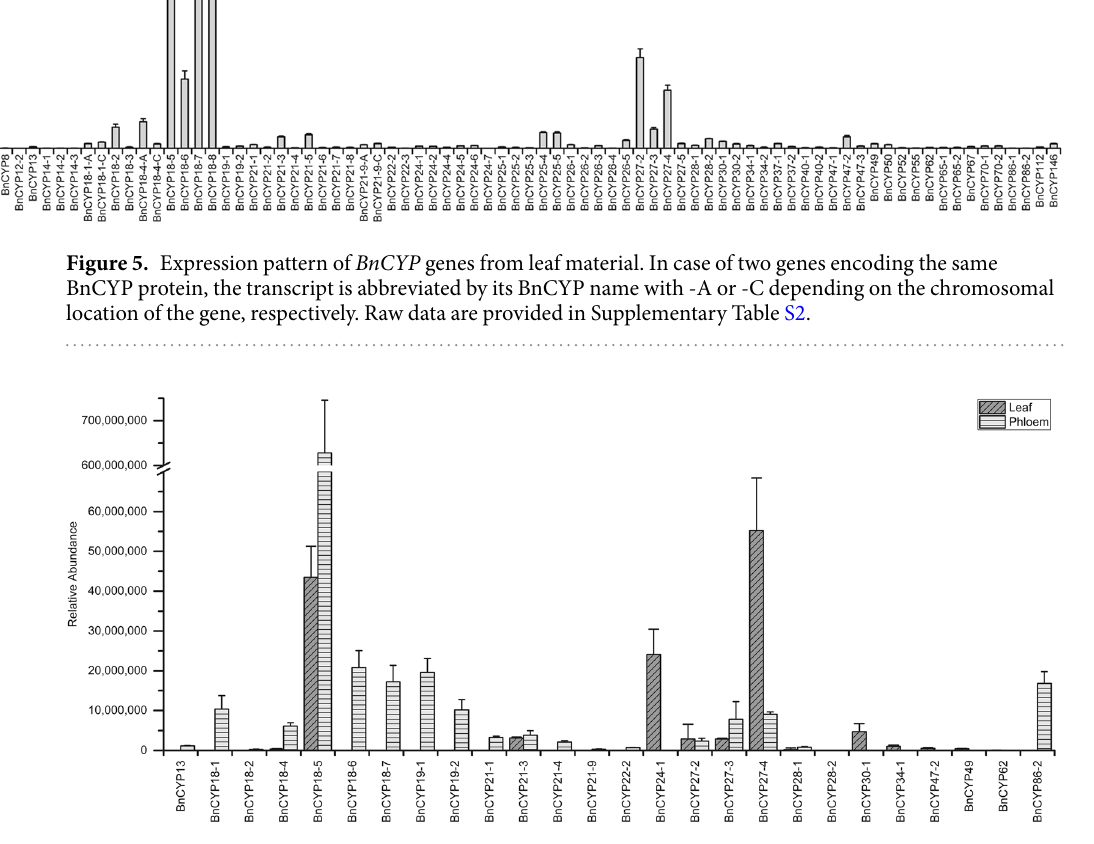
Figure 6. Relative abundance of leaf and phloem BnCYP proteins. The relative abundance of each BnCYP refers to the abundance of its unique peptides either from leaf extract (n = 3) or phloem sap (n = 4)